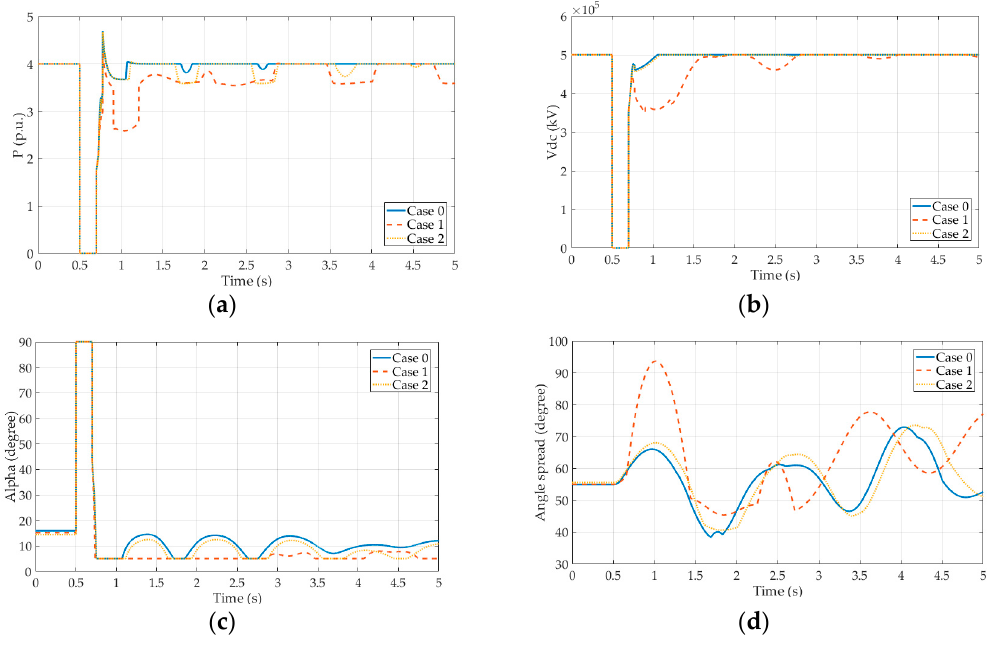
Figure 8. Existing HVDC in test system performance from the transient stability simulation: ( a ) active power transmission; ( b ) DC voltage of rectifier; ( c ) alpha angle; and ( d ) angle spread of AC system.